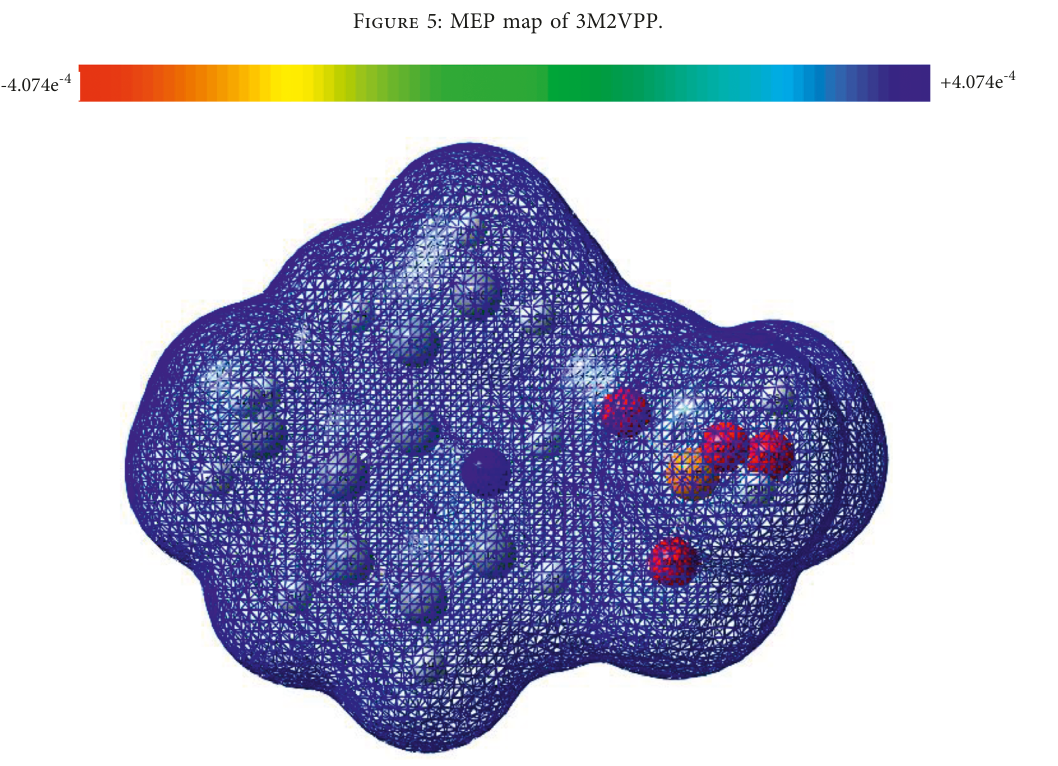
Figure 5: MEP map of